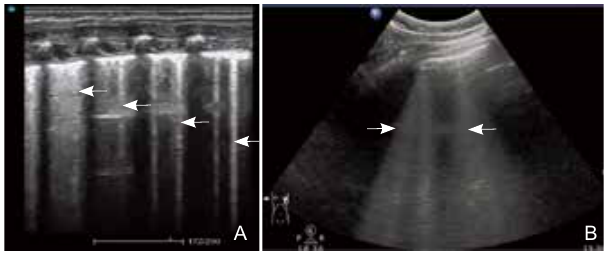
Figure 2 B-line radiates perpendicularly from the pleural line, reaching the deep echo of the lung field. (A) linear array and (B) convex array probe images show B line (arrows).